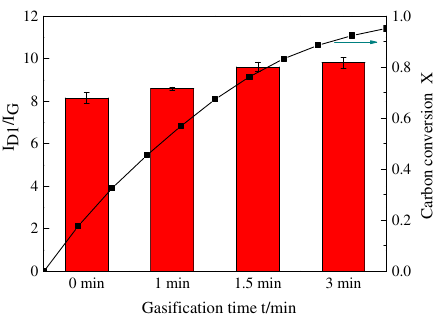
Fig. 9 Relationship between I D1 / I G and catalytic reactivity of different YCW semi-chars with 5 wt% IWC loaded at 1000